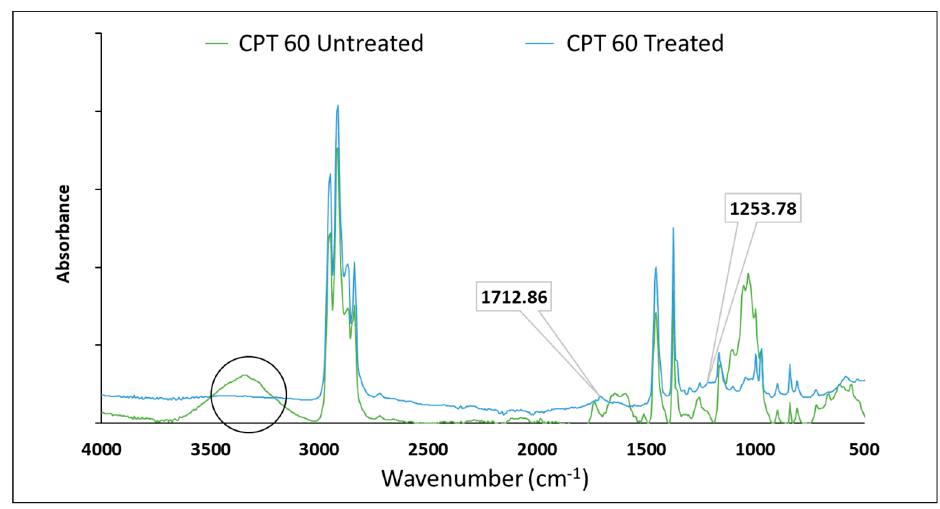
Figure 2. Fourier Transform Infrared Spectroscopy (FTIR) for treated and untreated composites (35% polypropylene + 60% thermomechanical fiber).